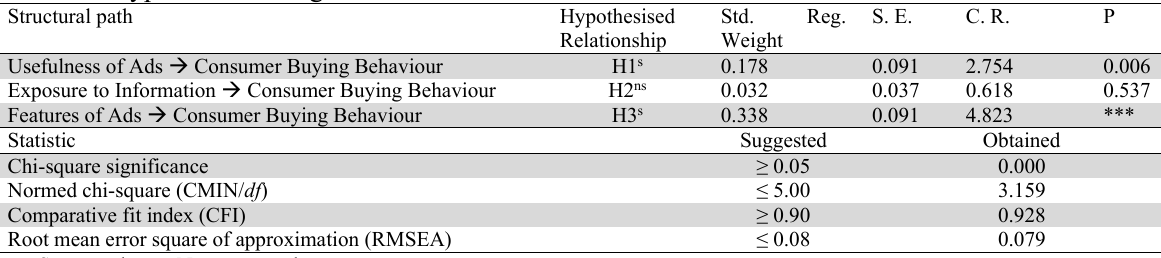
Results of hypotheses